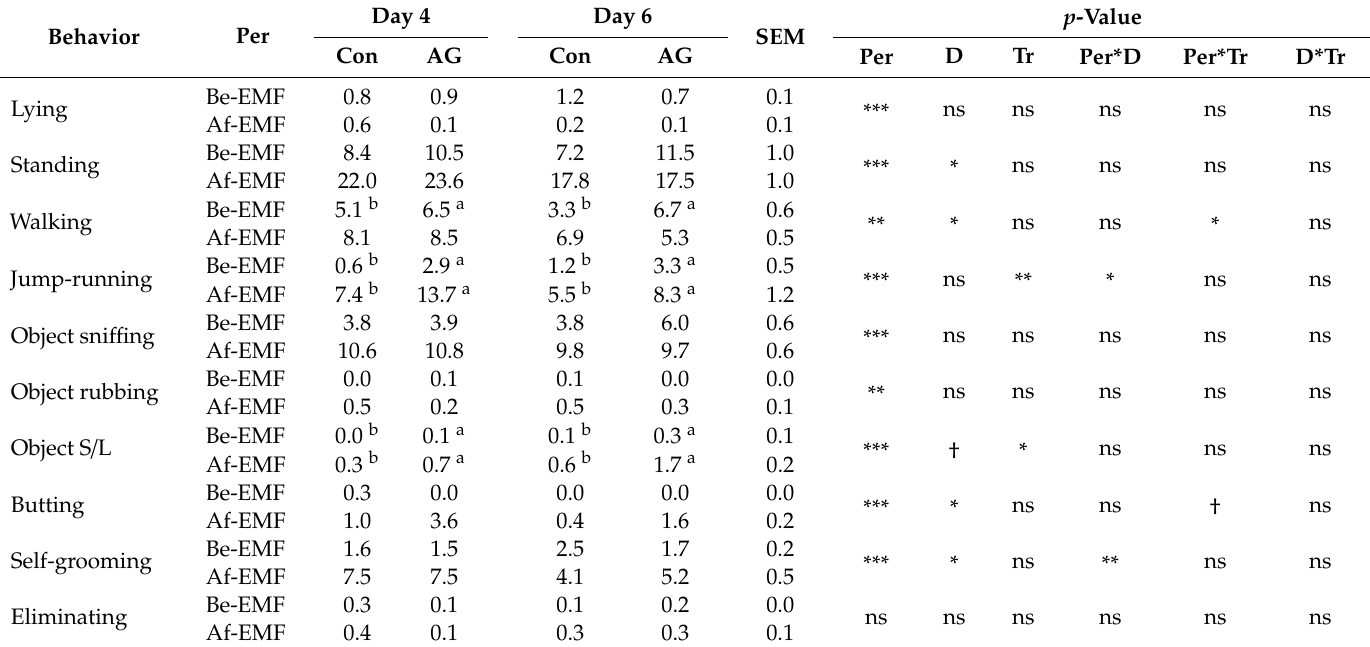
Table 3. The e ff ect of artificial grooming on the behavior bouts of Holstein female calves before and after evening milking feeding on days 4 and 6. Behavior